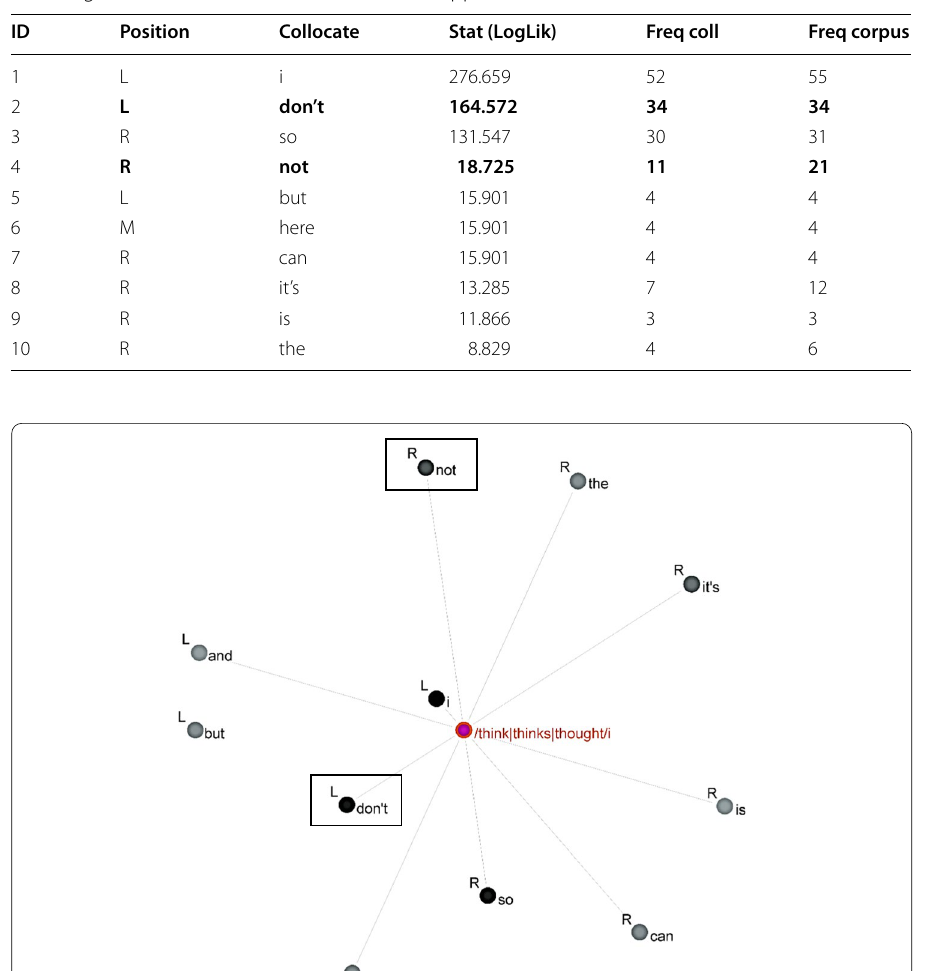
Fig. 1 Collocation network: think|thinks|thought in Easson Corpus of Transferred Negation (06—LogLik (6.63), L5-R5, C: 3.0-NC: 3.0; no filter